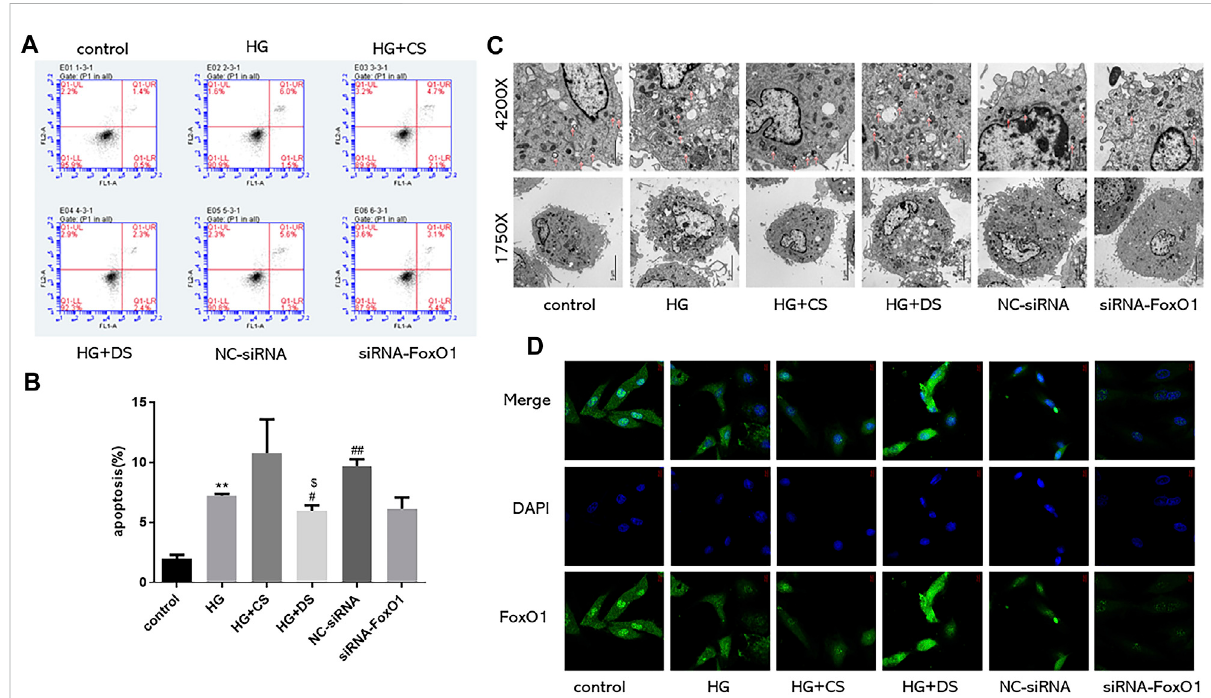
FIGURE 13 Flowcytometrywasusedtodetecttheproportionofapoptoticcells(n=3) (A,B) ;ObservationofautophagosomesinH9c2cellsunderelectron microscope (Magni fi cation of ×1750 and 4200× respectively) (C) ; Immuno fl uorescence of FoxO1 expression in H9c2 cells under fl uorescence microscope (630×) (D) . ** p < 0.01 vs. control group; # p < 0.05 vs. HG group; ## p < 0.01 vs. HG group; $$ p < 0.01vs. control group for each